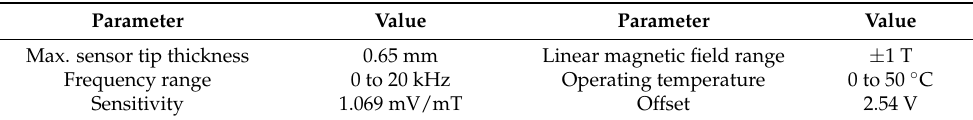
Table 4. Key specifications for the AN_180KIT Hall probe.